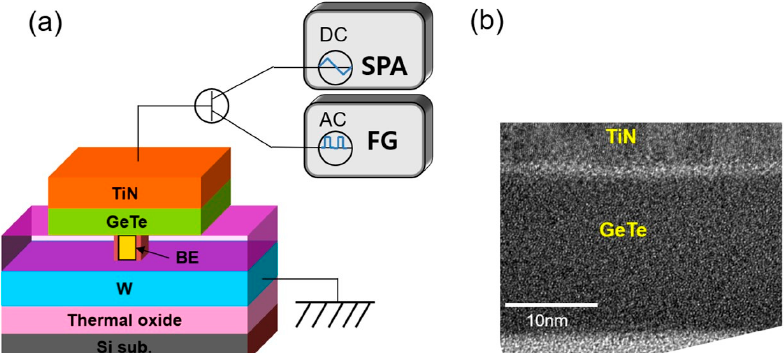
Figure 1. ( a ) Schematics of the fabricated planar-type phase change memory device (TiN / GeTe / TiN (TGT) and TiN / GeTe / W (TGW)) and electrical measurement system (SPA: semiconductor parameter analyzer; FG: arbitrary function generator). ( b ) Cross-sectional TEM image of TiN / GeTe stack in TGT